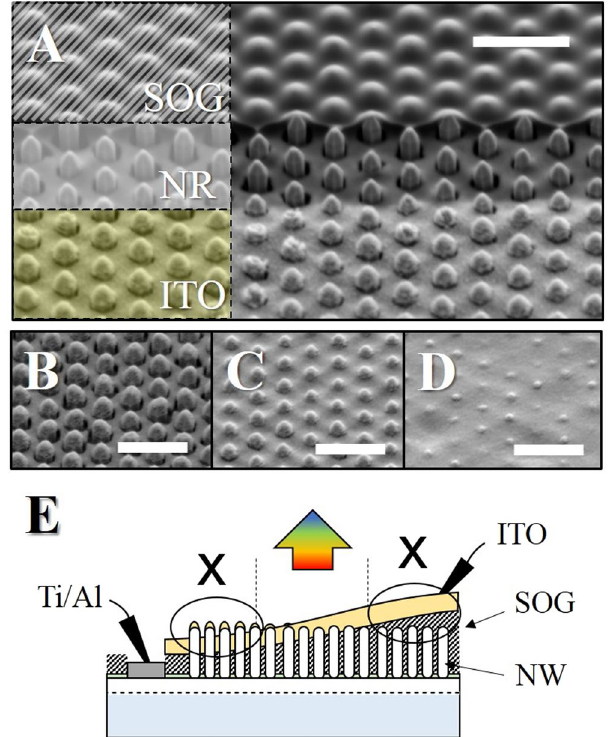
Figure 4. SEM 45° tilted view of the processed device ( A ). For easy understanding, the SOG and ITO layers are shaded similar in the images and in the schematic side view ( E ). NRs in ( B and D ) are not electrically connected, due to an over- ( B ) or under-etching ( C ) of the SOG. Picture C shows an area with correct contacts with functional NR-LEDs. The scale bar in each picture is 3 μ